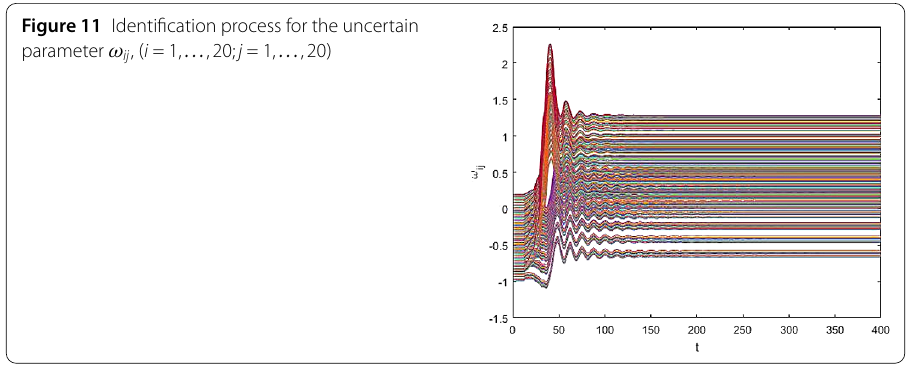
Figure 11 Identification process for the uncertain parameter ω ij , ( i = 1, ... ,20; j = 1, ... ,20)